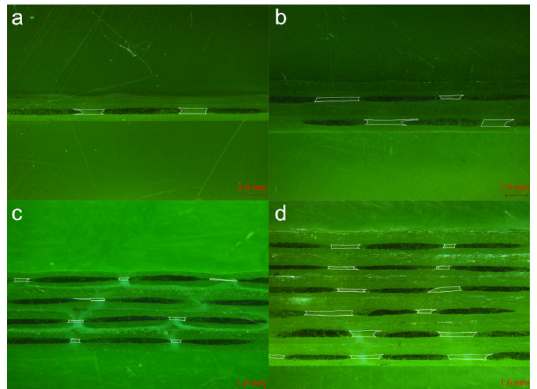
Figure 5. Warp cross-section views of ( a ) 1-layer; ( b ) 2-layer; ( c ) 4-layer and ( d ) 6-layer quadriaxial NCF reinforced laminates.